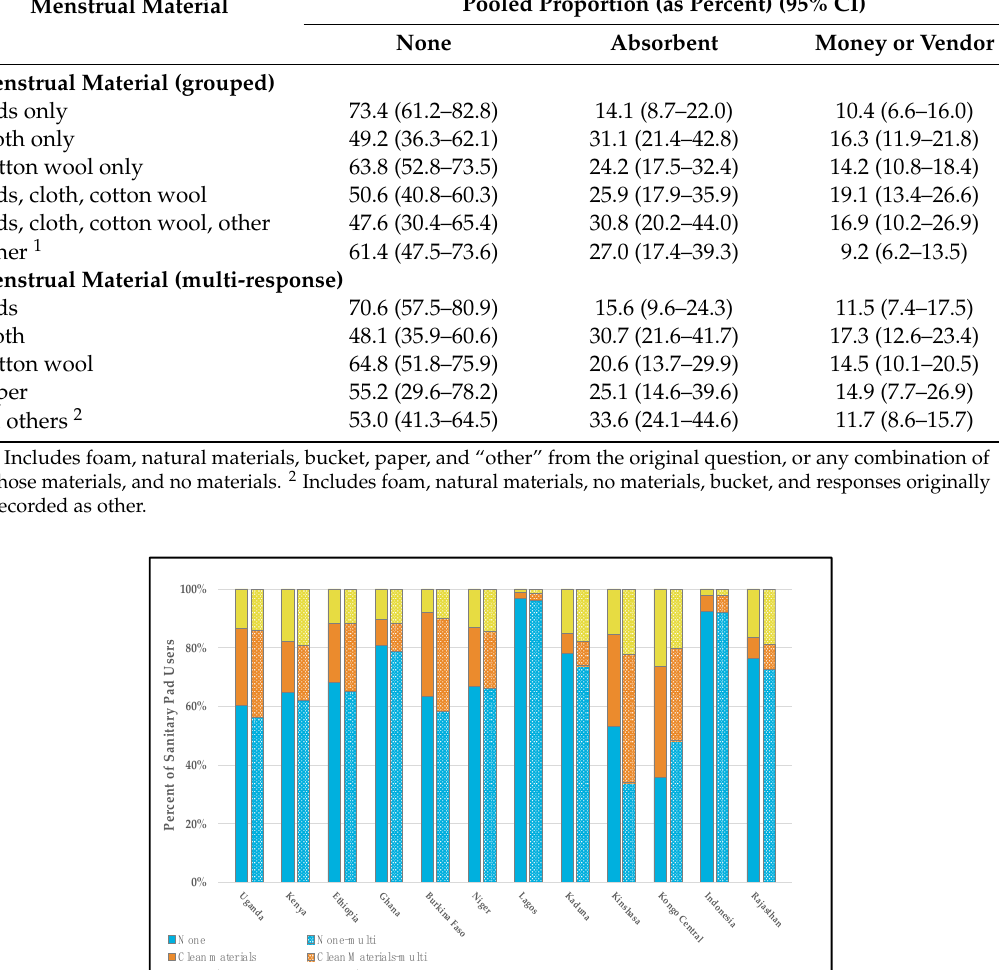
Figure 2. Reported menstrual material needs of cloth users whose cloth use was categorized using a single-response variable denoting exclusive cloth use (left) and a multi-response variable denoting any cloth use (right, patterned). Response options included no material needs (blue, bottom), clean materials (orange, middle), and money/vendor (yellow, top).